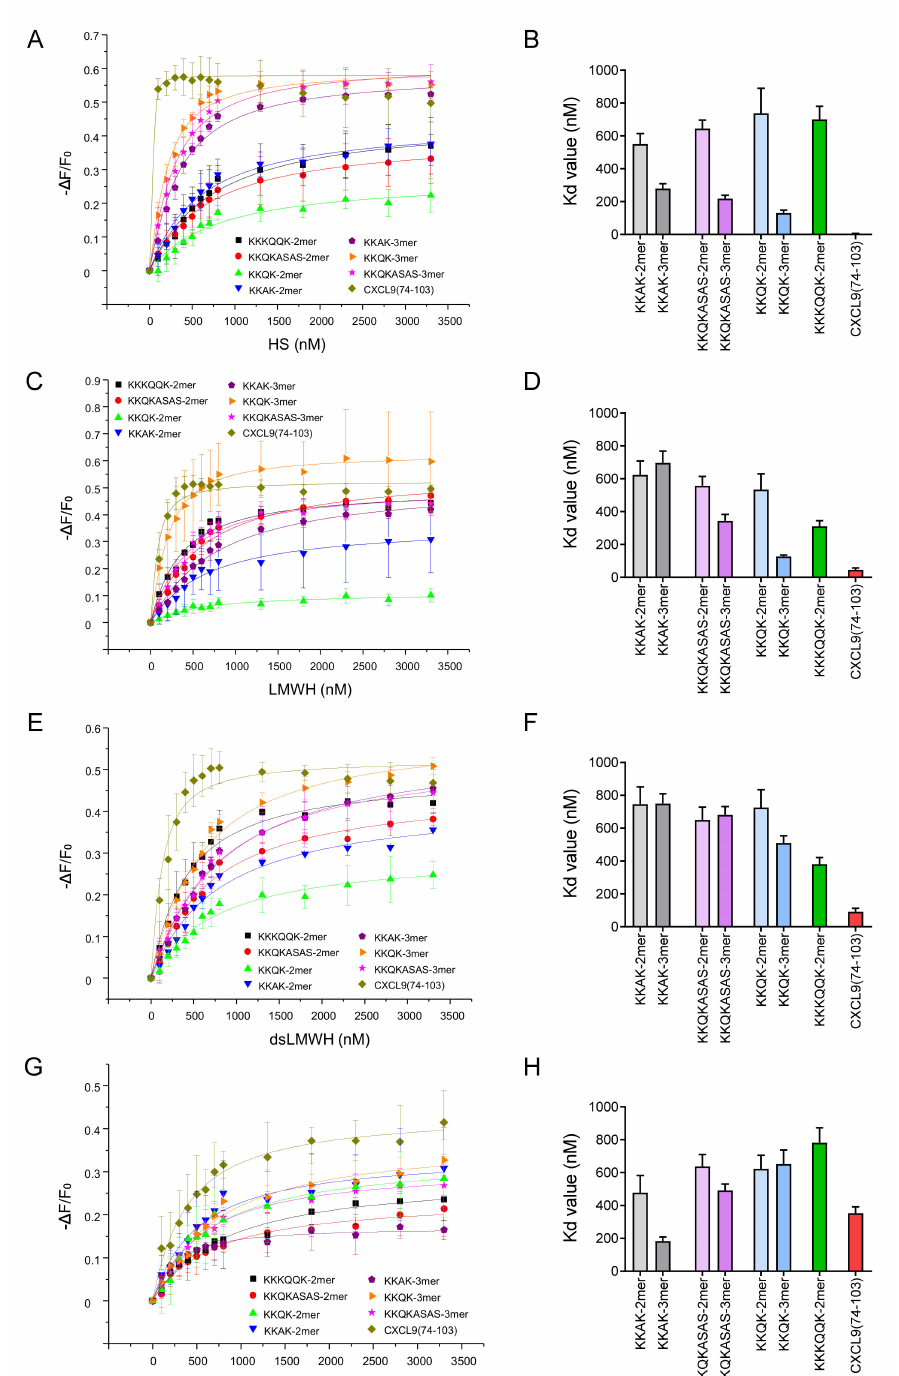
Figure 2. Peptides with more GAG-binding motifs have higher affinity for HS. Isothermal fluores- cence titration (IFT) measurements were performed to study the interactions between TAMRA-labeled peptides and different GAGs. ( A ) Binding isotherms for the different peptides are displayed per GAG: ( A ) HS; ( C ) LMWH; ( E ) dsLMWH; ( G ) HA. The change in fluorescence intensity ( ∆ F) divided by the intrinsic fluorescence of the peptide (F 0 ) is shown on the y-axis. ∆ F is calculated by subtracting F 0 from the fluorescence emission measured at a certain GAG concentration ( F ). The concentration of added GAG is shown on the x-axis. Data points represent mean values ± SEM ( n = 3). Dissociation constant (K d ) values ( ± SD) that are derived from the binding isotherms are visualized in bar plots per GAG: ( B ) HS; ( D ) LMWH; ( F ) dsLMWH; ( H )